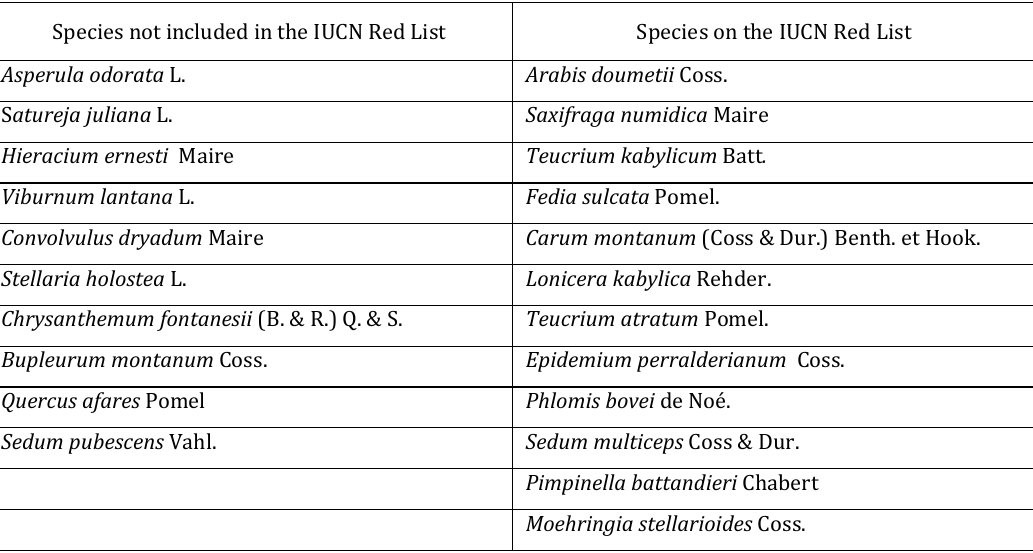
Table 5. Eigenvalues from factorial correspondence analysis